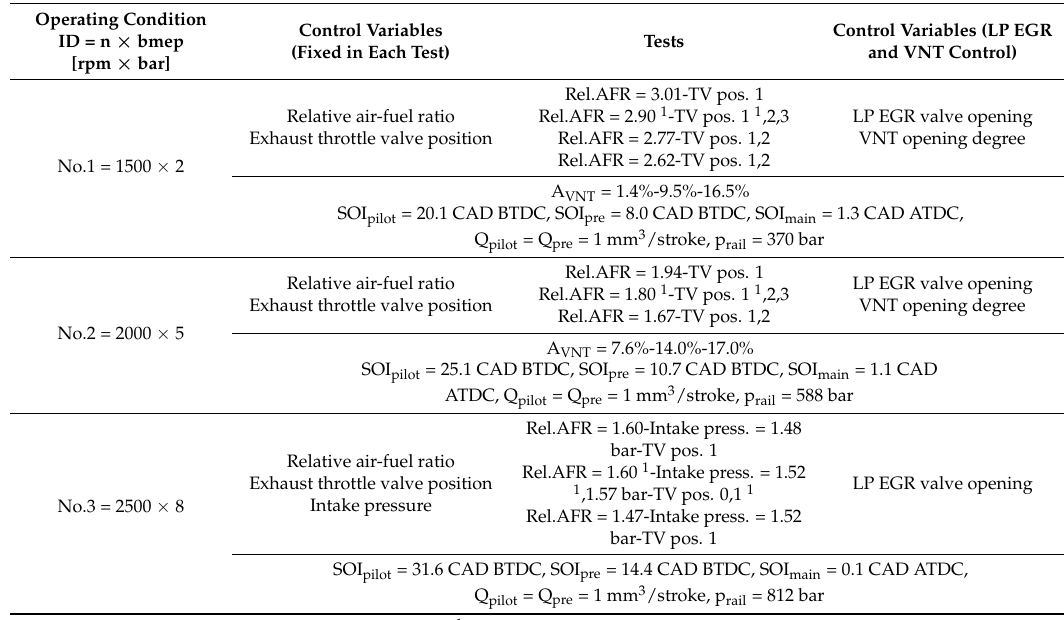
Table 5. Schedule of experimental activities for test Set